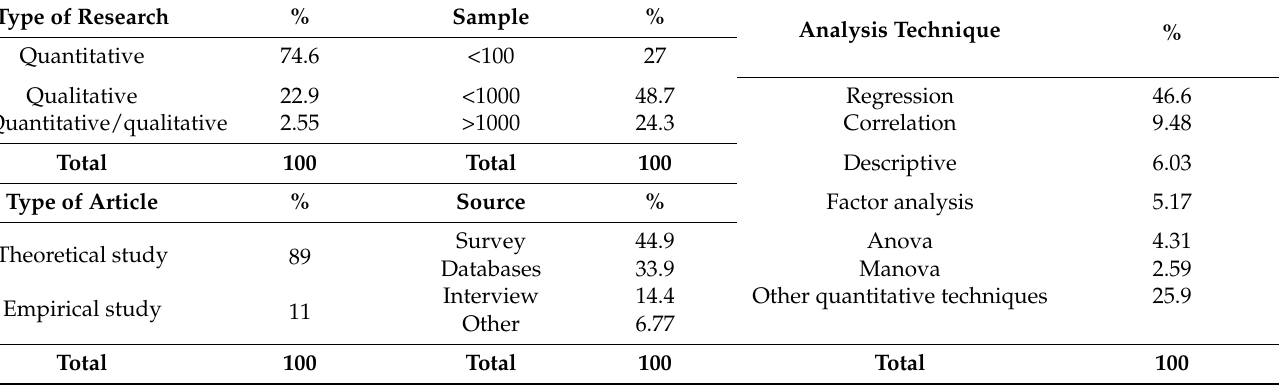
Table 1. Methodological parameters.